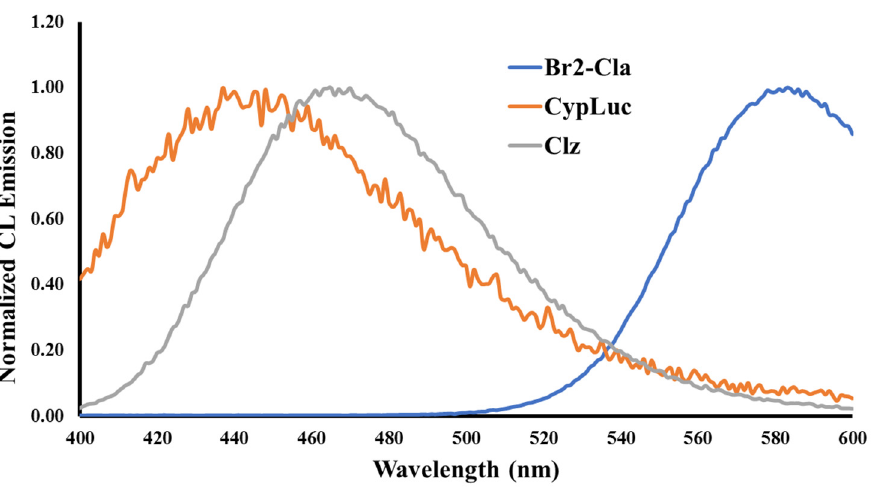
Figure 3. Normalized chemiluminescent emission spectrum of Br2-Cla, CypLuc and Clz, measured in DMF.